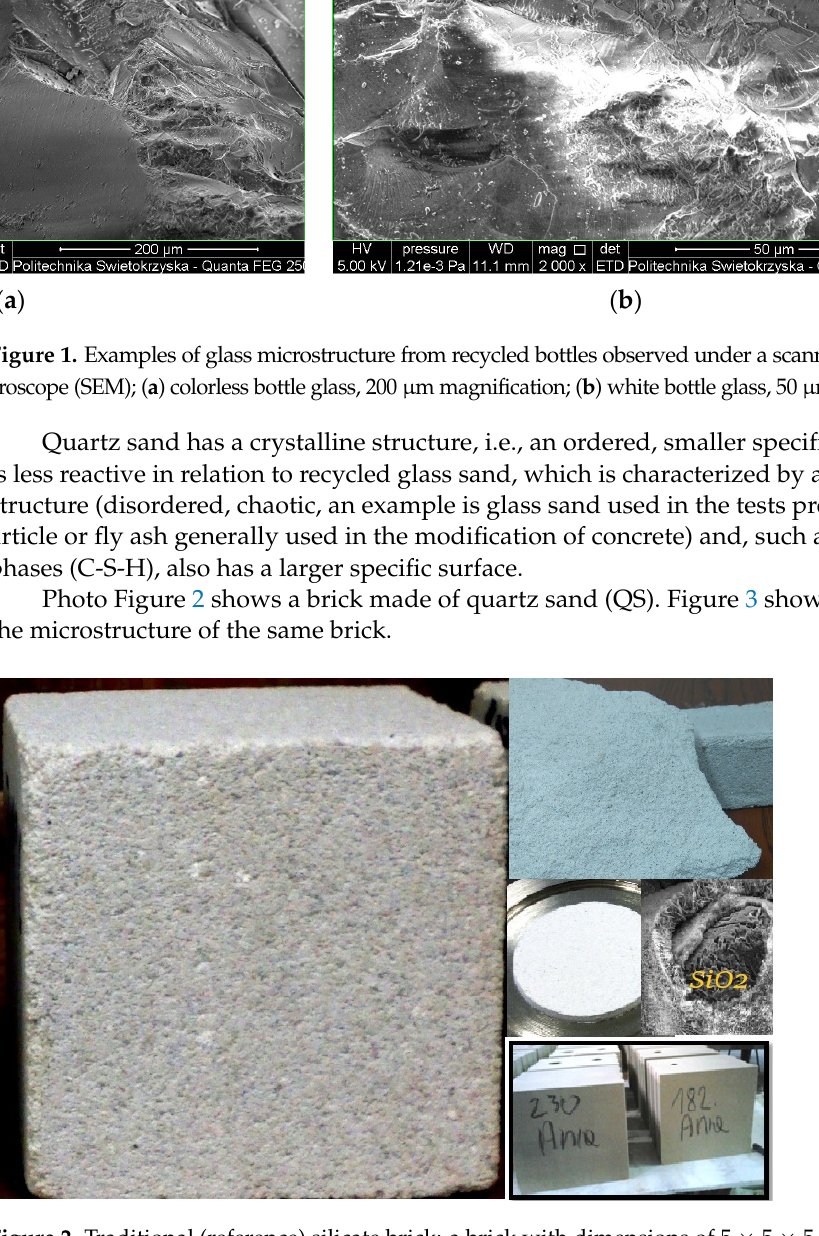
Figure 2. Traditional (reference) silicate brick: a brick with dimensions of 5 × 5 × 5 cm and a break through the structure of the brick.